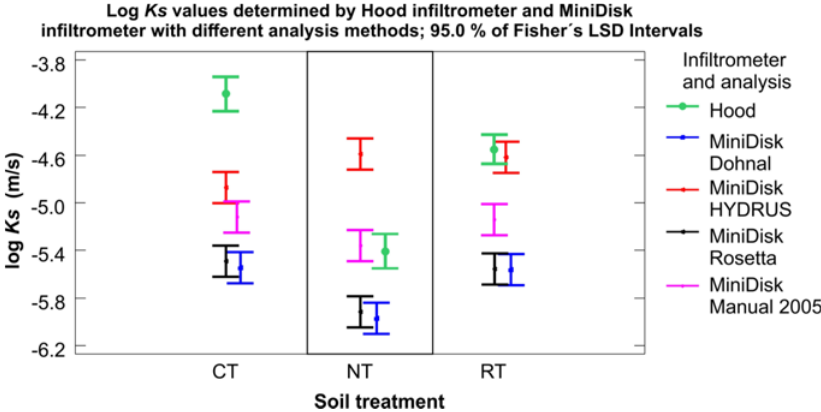
Figure 7. ANOVA results for log Ks data determined by HI and MDI with different applied data analyses.